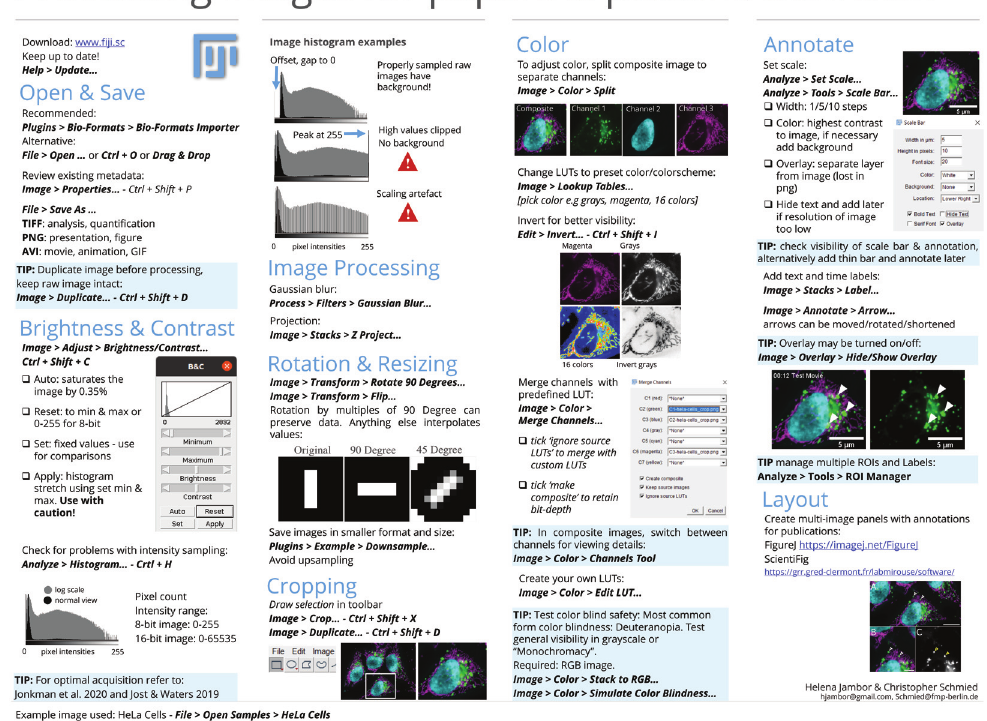
Figure 3. Cheat sheet 1: processing images for papers and posters 45 .